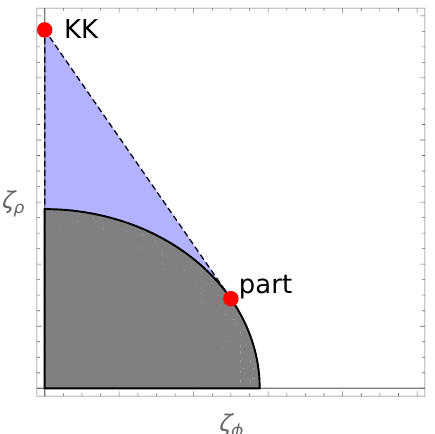
Figure 1. Kaluza-Klein reduction and the convex hull condition. The convex hull generated by q q q the vector ~ζ = (0 , ) ~ζ = ( ) lies outside the ball of radius n + d − 2 1 n , KK part n ( d − 2) n + d − 2 ( n + d − 2)( d − 2) √ 1 / d − 2 , so the Distance Conjecture will be satisfied with a coefficient λ lightest ≥ 1 / every direction ˆ ρ, ˆ φ → ∞ with ˆ ρ/ ˆ φ ≥ p n/ ( d − 2) . Figure adapted from